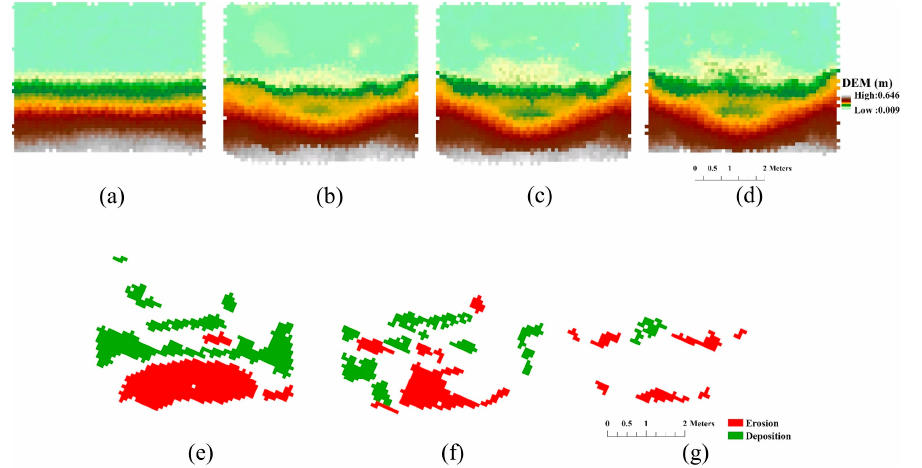
Figure 13. Beach evolution based on CMA analysis and beach models with 10 cm resolution. The upper figures are beach models showing initial model ( a ) and models after one ( b ), two ( c ), and three ( d ) periods of wave application. ( e , f ) show the changing areas of sediment erosion and deposition between consecutive beach models that occurred after one ( e ), two ( f ), and three ( g ) periods of wave application. Each period of wave application lasted 10 min.